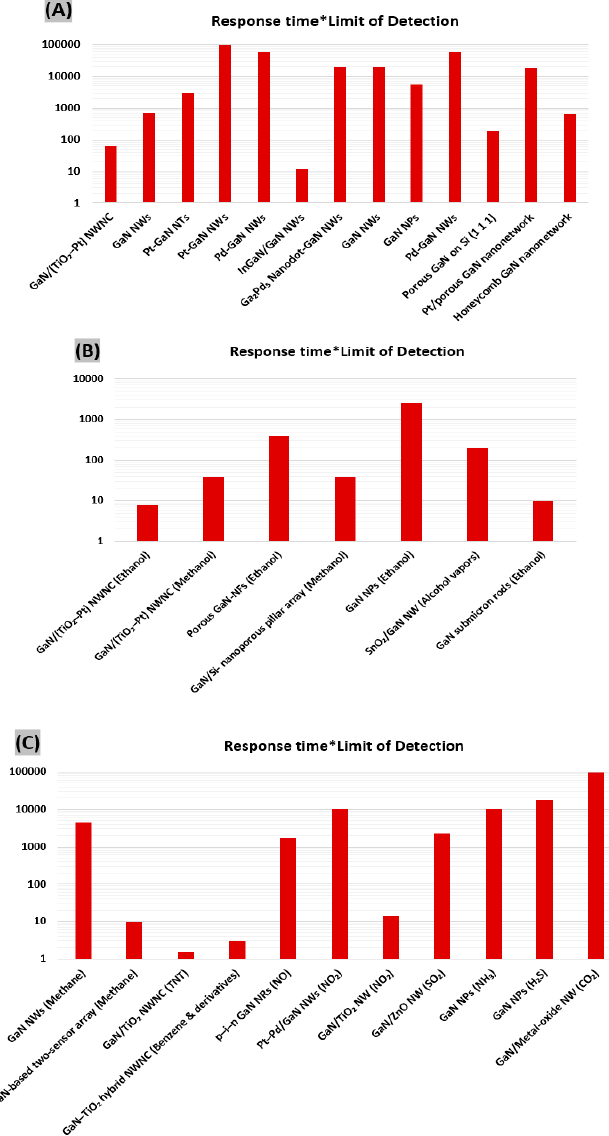
Figure 6. Comparison of the product of response time and limit of detection value among previously reported GaN nanostructures-based sensors for ( A ) H 2 , ( B ) alcohols, and ( C ) other gases.